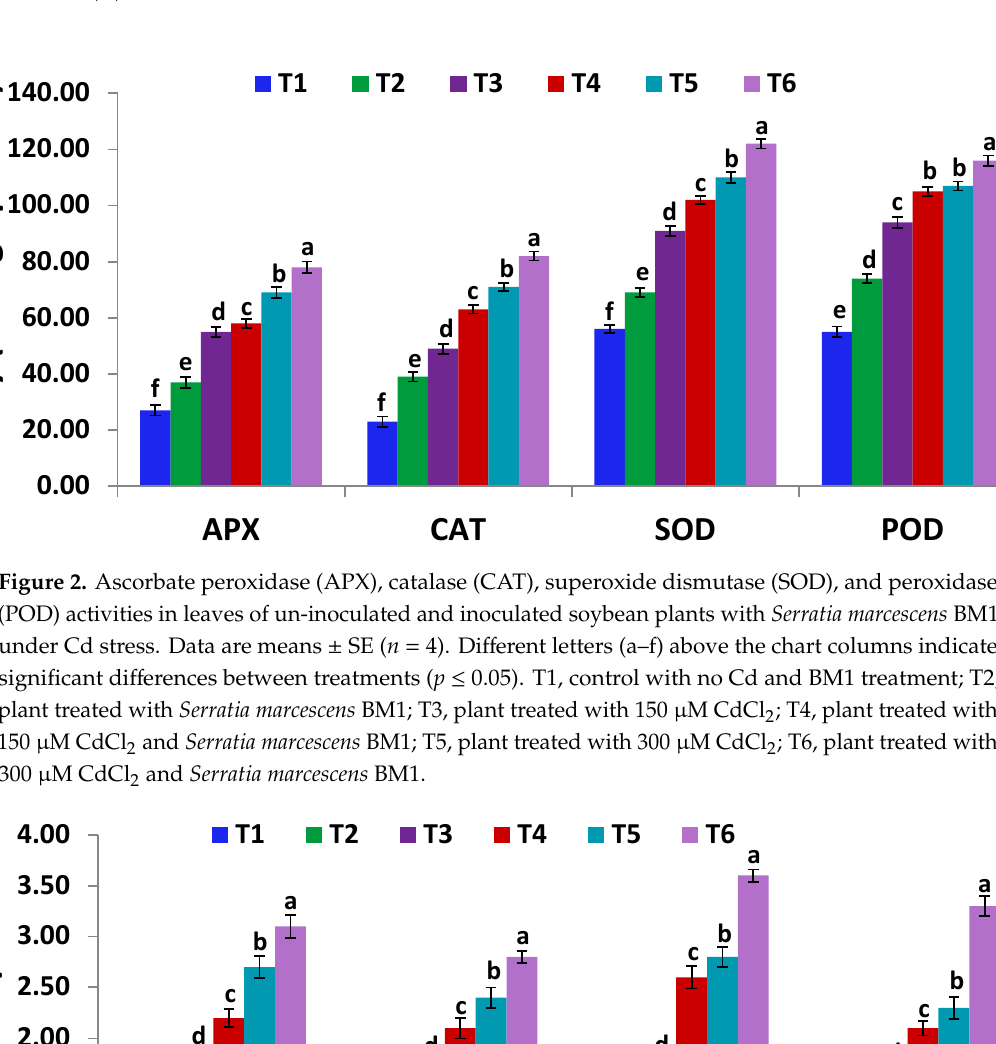
Figure 4. Expression levels of CHI, CHS, PHD2, VSP, NR and P5CS genes in leaves of un-inoculated and inoculated soybean plants with Serratia marcescens BM1 under Cd stress. Data are means ± SE (n = 4). Different letters (a–f) above the chart columns indicate significant differences between treatments ( p ≤ 0.05). T1, control with no Cd and BM1 treatment; T2, plant treated with Serratia marcescens BM1; T3, plant treated with 150 µM CdCl 2 ; T4, plant treated with 150 µM CdCl 2 and Serratia marcescens BM1; T5, plant treated with 300 µM CdCl 2 ; T6, plant treated with 300 µM CdCl 2 and Serratia marcescens BM1.